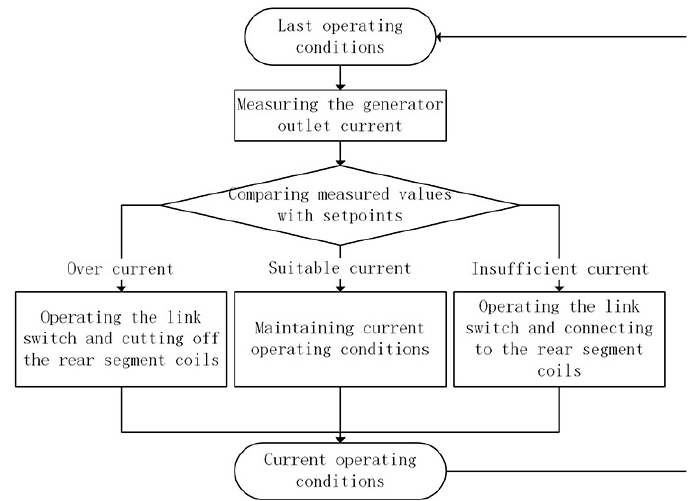
Figure 3. Coils switching